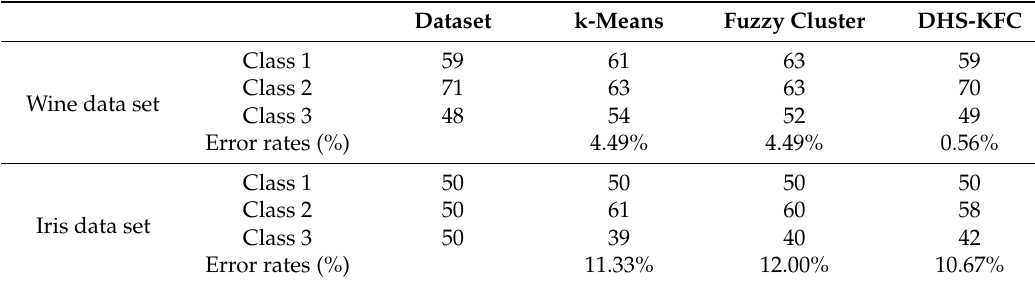
Table 10. Results of the clustering method.